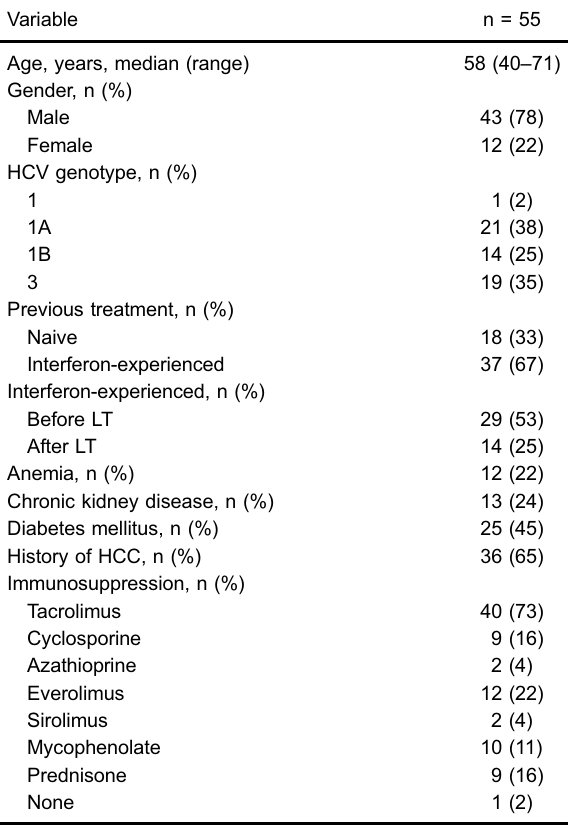
Table 1. Patient demographics and baseline characteristics.